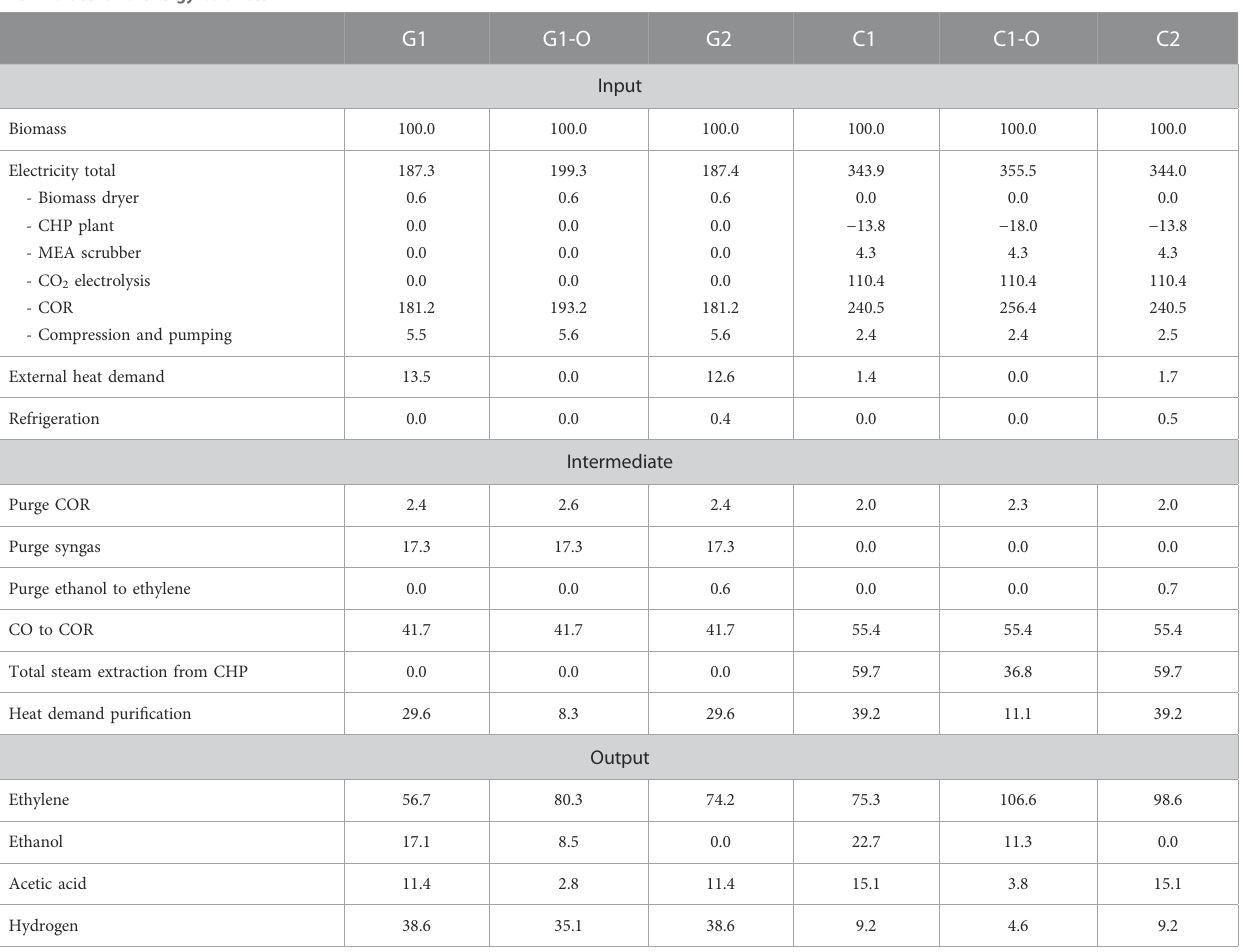
TABLE 6 Scenario energy balances in